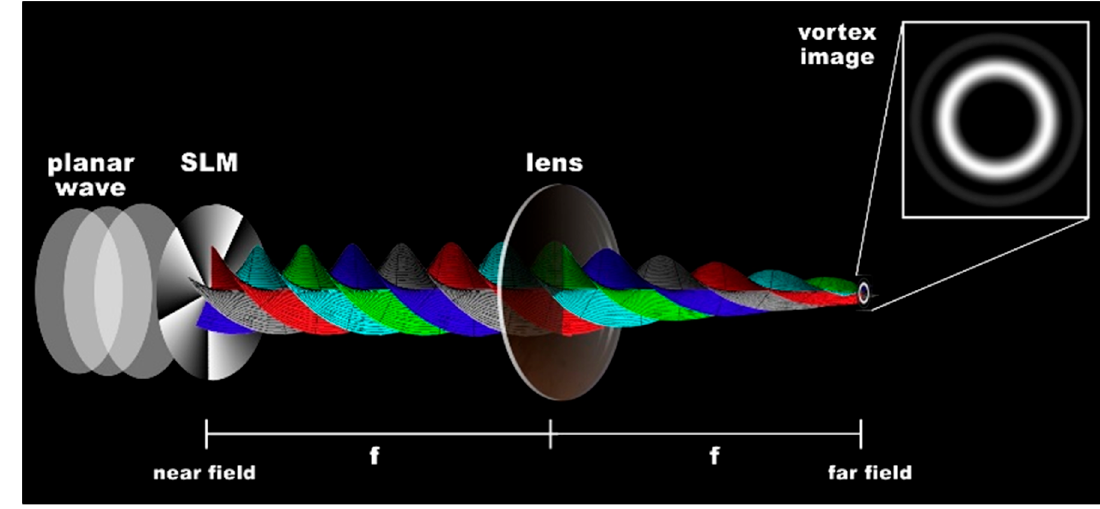
Figure 6. Spatial modulation in the far field from phase modulation in the near field with a 2f